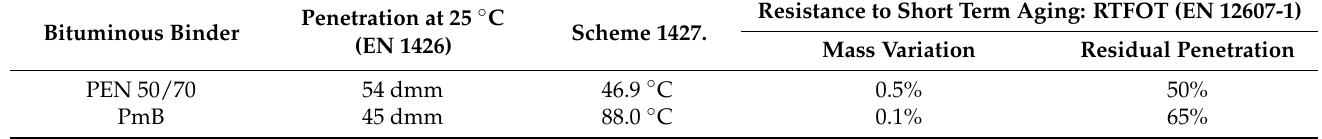
Table 1. Technical properties of PEN 50/70 and PmB.